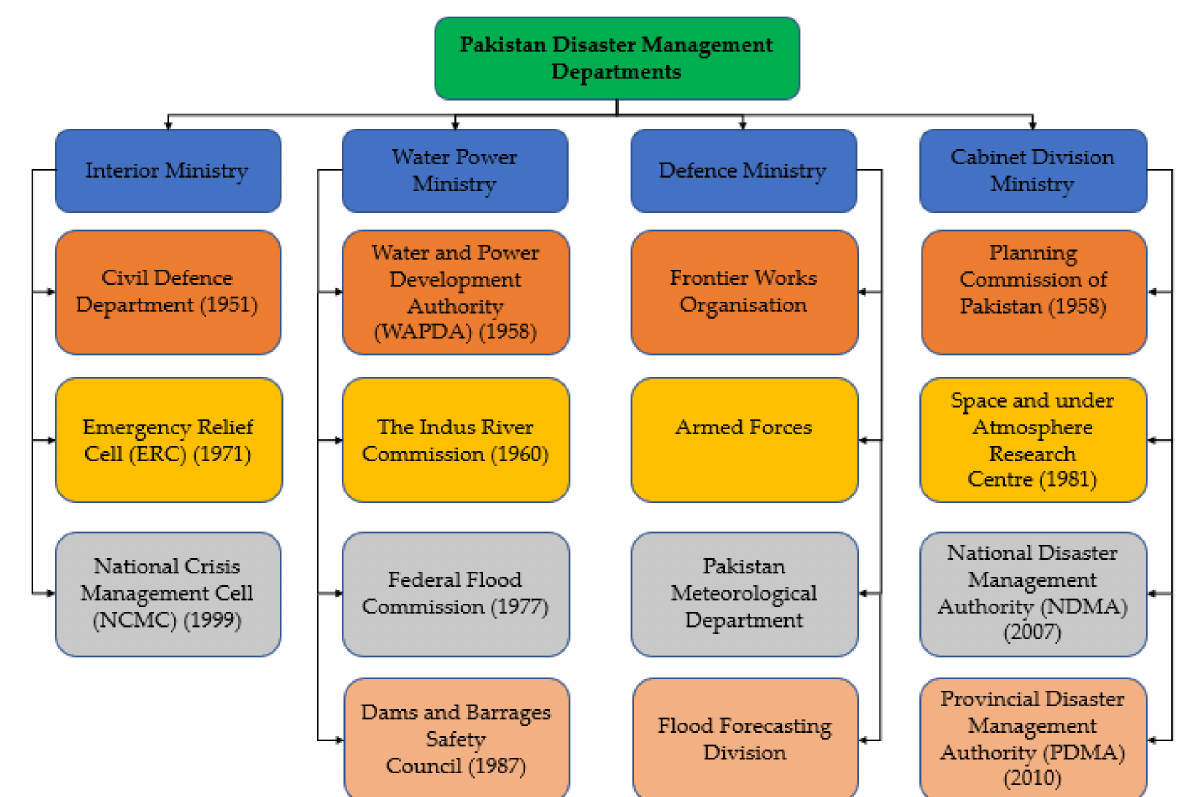
Figure 18. Multi Hazards Risk Management Departments of